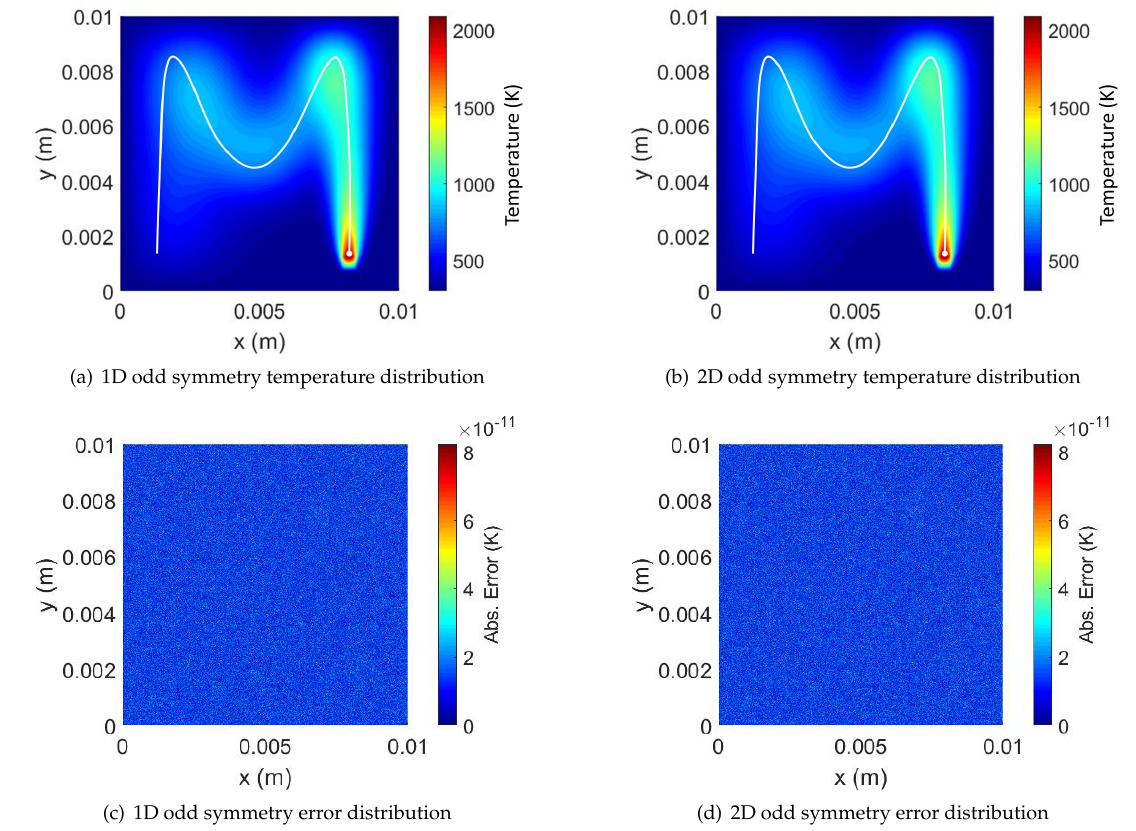
Figure 9. Temperature and absolute error distributions (w.r.t. the brute-force approach [24]) on the thin plates for the odd symmetry FFT approaches (1D and 2D).